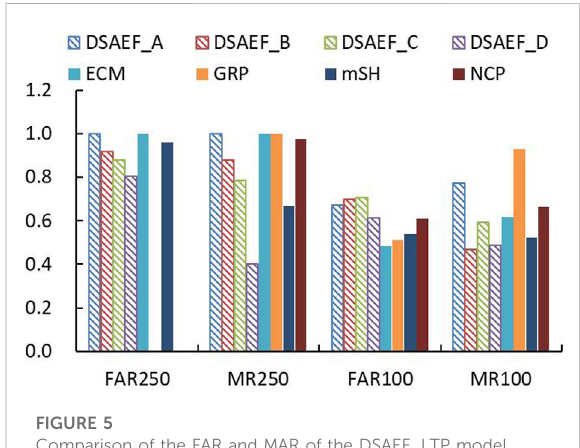
FIGURE 5 Comparison of the FAR and MAR of the DSAEF_LTP model withfournumericalmodels(ECM,GRP,NCP,mSH)inindependent forecast experiments in Fujian